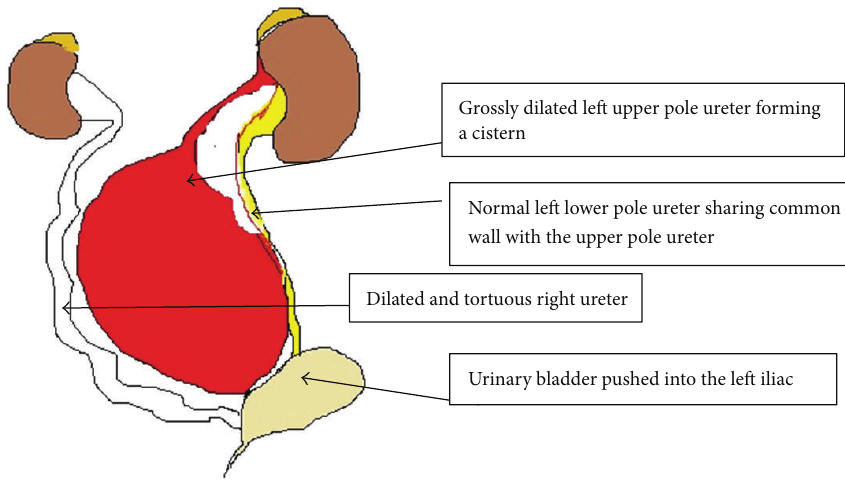
Figure 5: Schematic drawing of the intraoperative